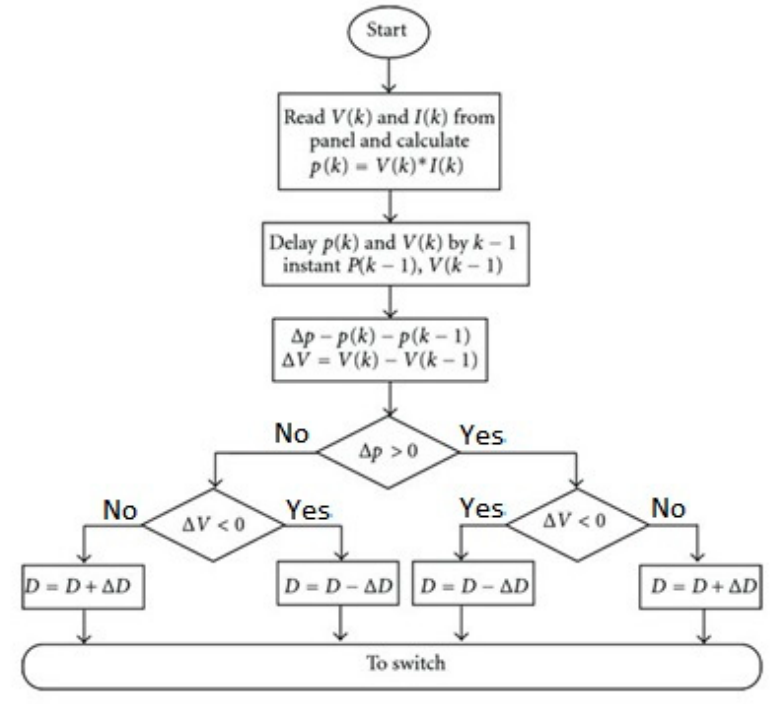
Figure 6. Flowchart of the MPPT algorithm [23].